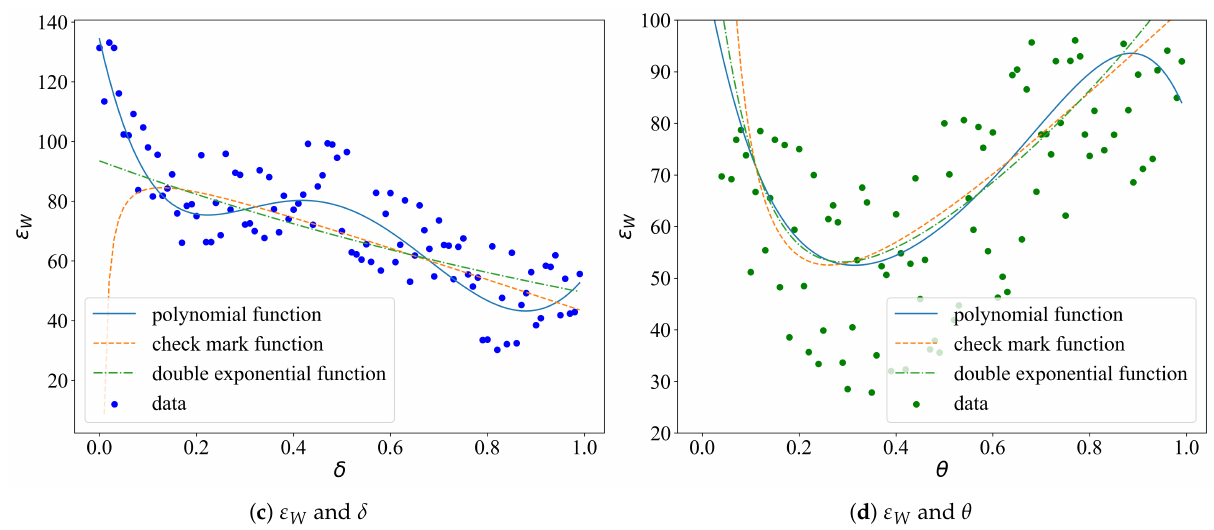
Figure 8. The fitting curves of ε S , ε W and δ , θ .